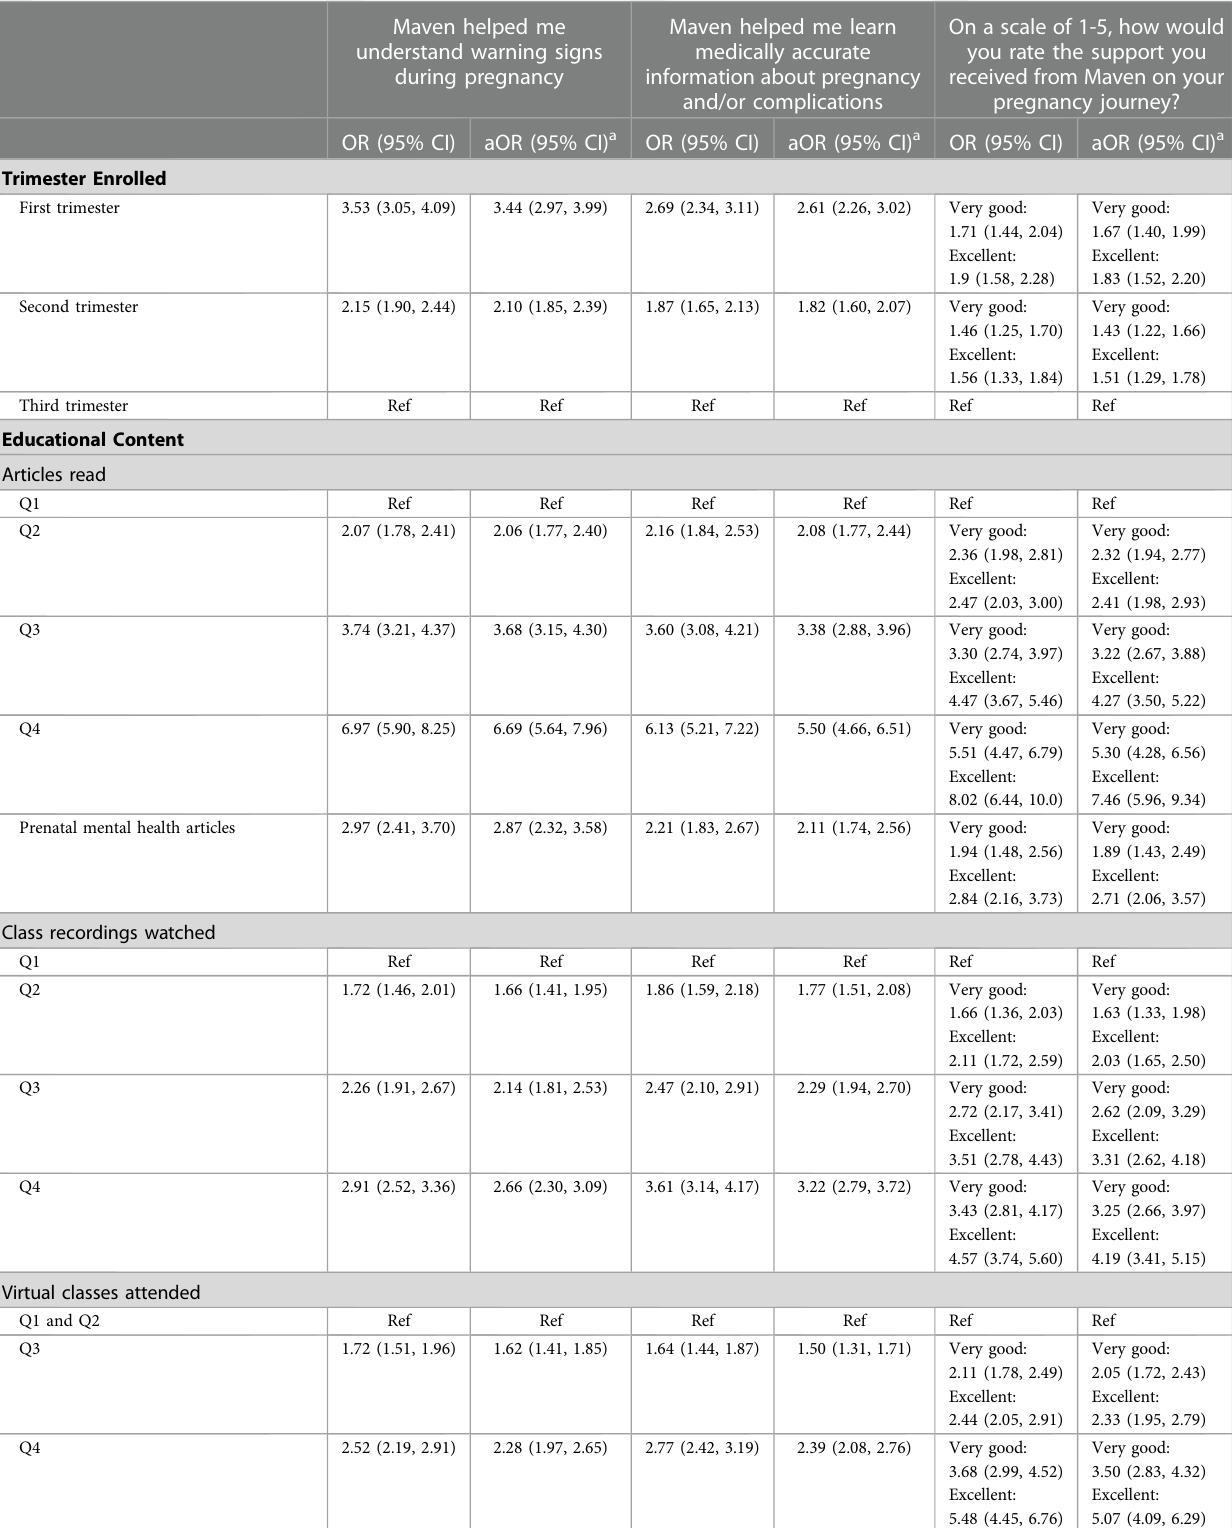
TABLE 3 effect of utilization on understanding warning signs in pregnancy, learning medically accurate information about pregnancy, and feeling supported.